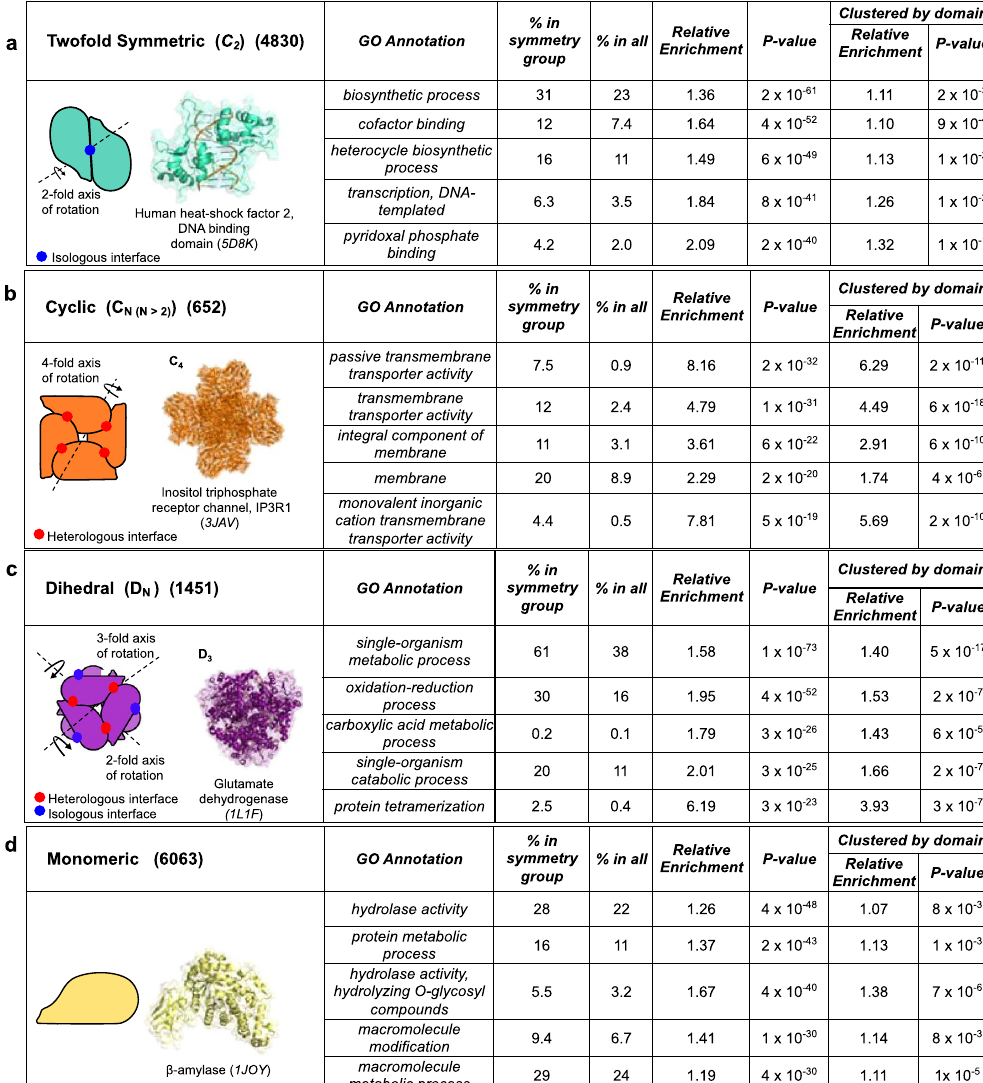
Figure 1. The top five most significant positively enriched non-redundant GO terms within each symmetry group in the sequence filtered set of proteins are tabulated with their associated P -value from Fisher ’ s Exact Test. The equivalent enrichment and P-values in the more stringent, domain-filtered, set is also shown for comparison. ( a ) Twofold symmetric homomers are associated with annotated functions that involve small and/ or twofold symmetric binding partners. Cartoon of a symmetric dimer illustrating the twofold rotation element and isologous interface (blue) with the DNA-binding domain of a heat-shock transcription factor serving as an example. ( b ) Higher-order cyclic protein complexes are required for specialist architectures and are enriched in functional terms involving membrane structures. A C 4 symmetric complex with the fourfold rotation element and heterologous interfaces (red) highlighted. These interfaces are formed by a head-to-tail orientation of the protein subunits (orange). An inositol-1,4,5-triphosphate activated trans-membrane Ca 2 + ion channel illustrates an example. ( c ) Protein complexes with dihedral symmetries have a mixture of both isologous and heterologous interfaces and are enriched in metabolic processes. Dihedral complexes in group D N constitutes either N symmetric dimers or two symmetric N -mers. A D 3 dehydrogenase illustrates an example of a dimer- of-trimers with heterologous (red) interfaces in the head-to-tail trimers that form a dimer with isologous (blue) interfaces. ( d ) Monomers preferentially act together with large substrates. A β -amylase monomer from B. cereus illustrates an example